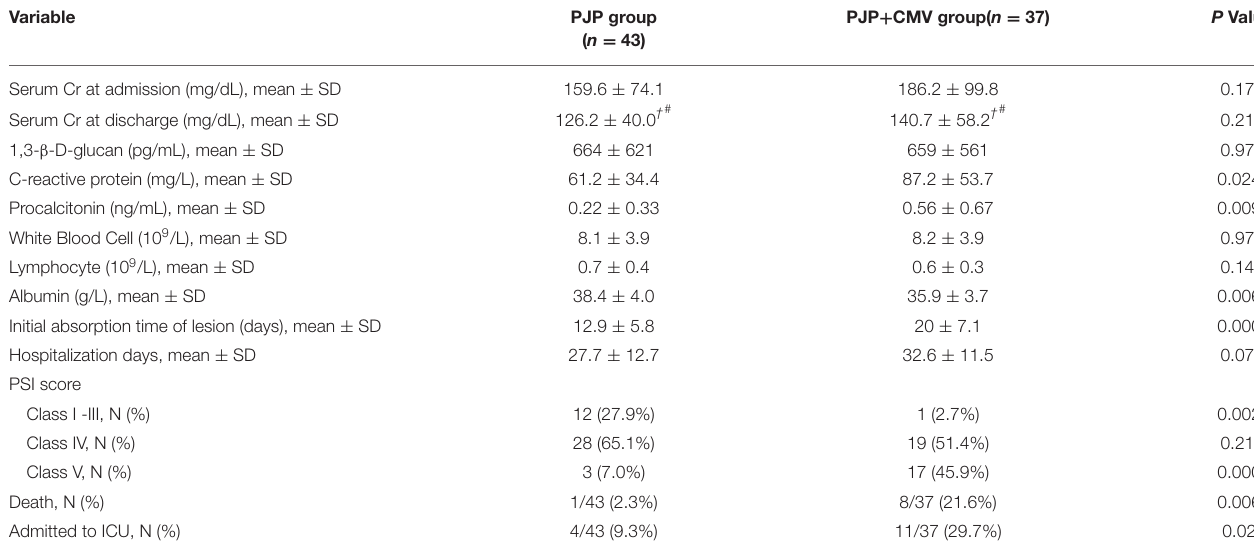
TABLE 2 | Comparison of laboratory findings and outcome between the PJP and PJP + CMV groups.